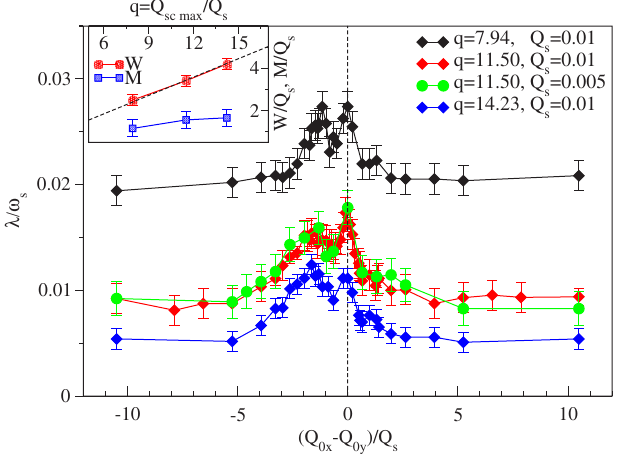
FIG. 6. Landau damping rate λ of the horizontal first space ω s ¼ ð Q − Q Þ =Q charge mode versus Δ Q 0 =Q for different 0 x 0 y s s values of the space charge parameter q and the synchrotron tune ¼ ω Q where ω 0 Q s is the synchrotron frequency. The width of s s the enhanced damping region in the proximity of coupling resonance W , defined at half maximum, scales linearly with the space charge tune shift, W ≈ 0 . 3 Q , as shown in the inset. sc max The enhanced damping region is asymmetric with respect the to Δ Q ¼ 0 , extending predominantly on the negative side of Δ Q 0 0 . Two maxima of the damping rate can be noticed, one at Δ Q 0 ¼ 0 and the other one at Δ Q 0 ≈ − M